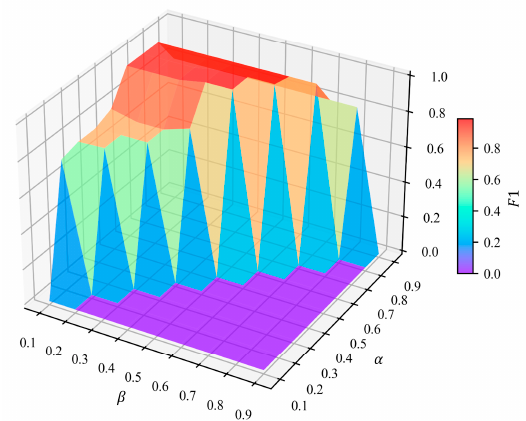
Figure 3. Breast’s 𝐹1 change chart. Figure 3. Breast’s F 1 change chart.